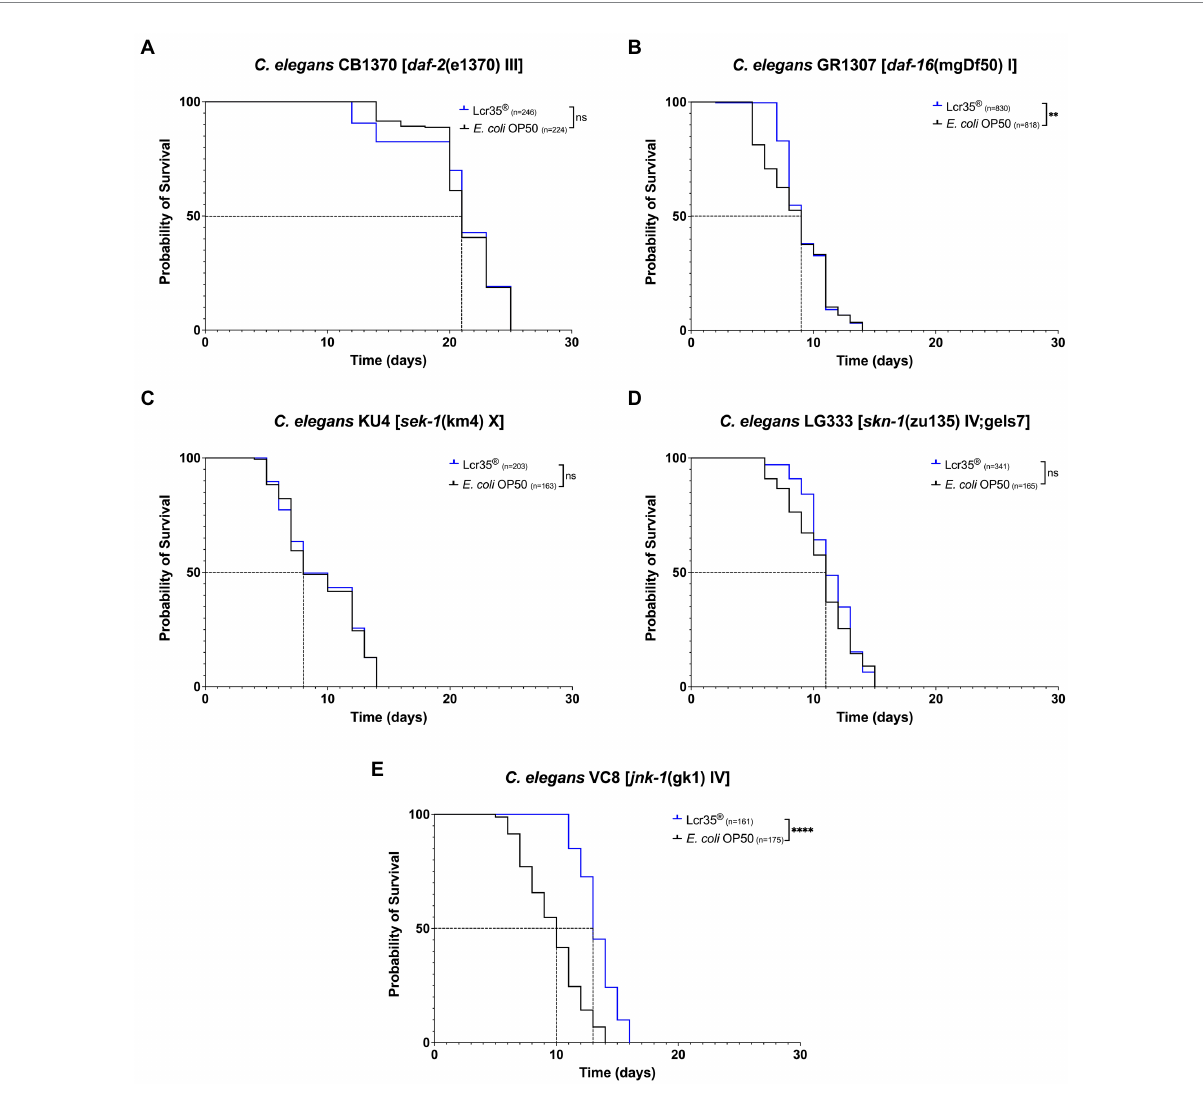
FIGURE 1 Influence of Lactobacillus rhamnosus Lcr35 ® on the lifespan of Caenorhabditis elegans daf-2 (CB1370) (A) , daf-16 (GR1307) (B) , sek-1 (KU4) (C) , skn-1 (LG333) (D) , and jnk-1 (VC8) (E) loss-of-function mutant strains. The mean lifespan, where half of the population was dead, is represented on the abscissa. The asterisks indicate the value of p s (log-rank test) with E. coli OP50 as a control (NS, not significant; ** p < 0.01; **** p <